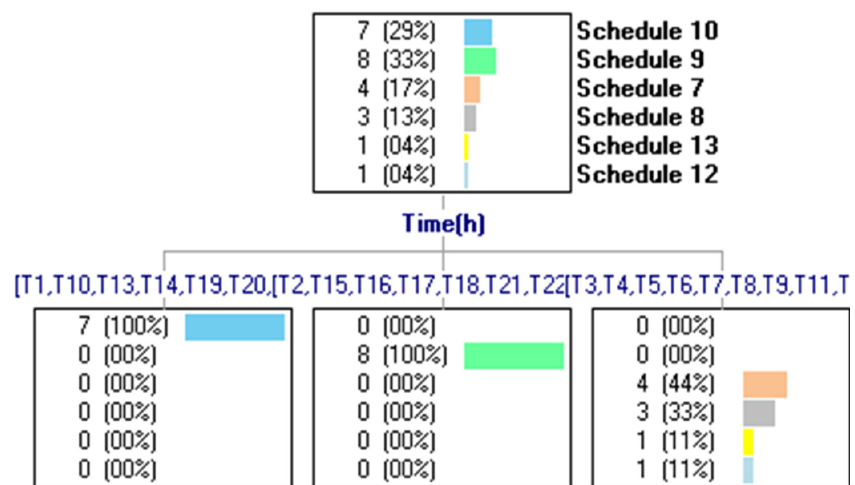
Figure 7. Decision tree generated by Chi-Squared Automatic Interaction Detection (CHAID) Tians- hengqiao plant 1 for the summer season.